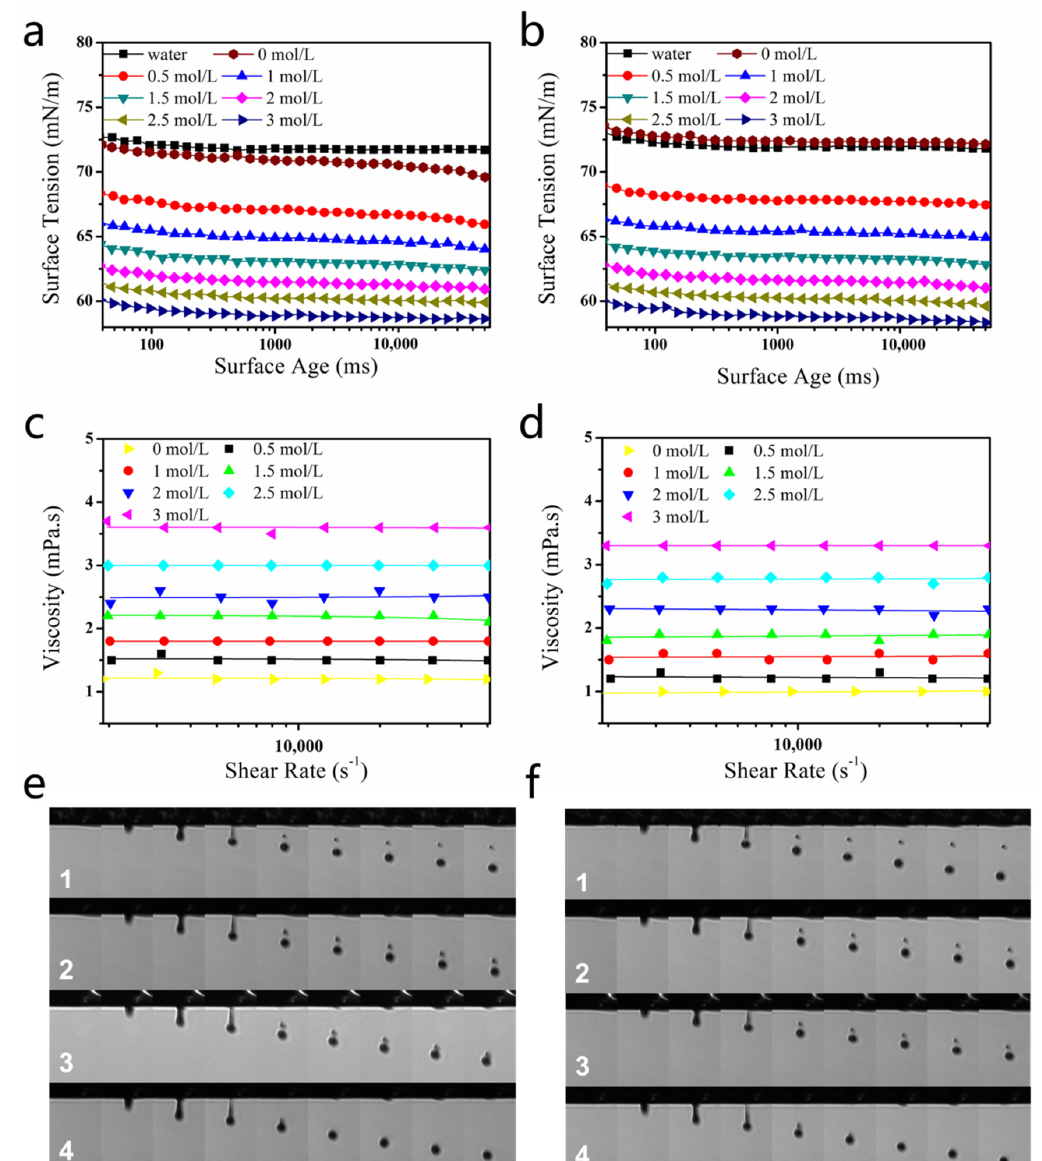
Figure 4. ( a , b ) Surface-tension values of 120 mmol/L dye solutions containing different amounts of DEG: ( a ) Reactive Blue 49 and ( b ) Reactive Orange 13. ( c , d ) Viscosity values of 120 mmol/L dye solutions with different amounts of DEG: ( c ) Blue 49 and ( d ) Orange 13. ( e ) Droplet formation of 120 mmol/L Reactive Blue 49 solution with different concentrations of DEG: ( 1 ) 0, ( 2 ) 1, ( 3 ) 2, and ( 4 ) 3 mol/L. ( f ) Droplet formation of 120 mmol/L Reactive Orange 13 dye solutions with different concentrations of DEG: ( 1 ) 0, ( 2 ) 1, ( 3 ) 2, and ( 4 ) 3 mol/L. Jetting frequency was 1000 Hz, temperature was 25 °C, and humidity was controlled in the range of 50–70%.